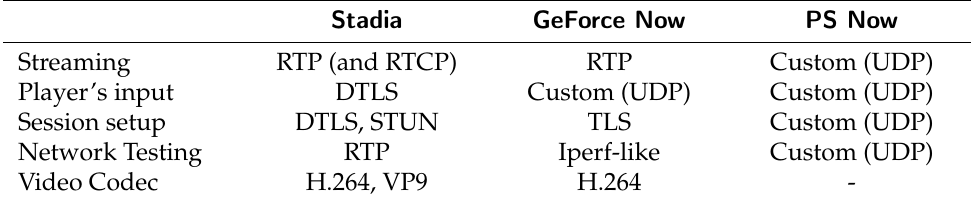
Table 2. Protocol usage for different gaming session